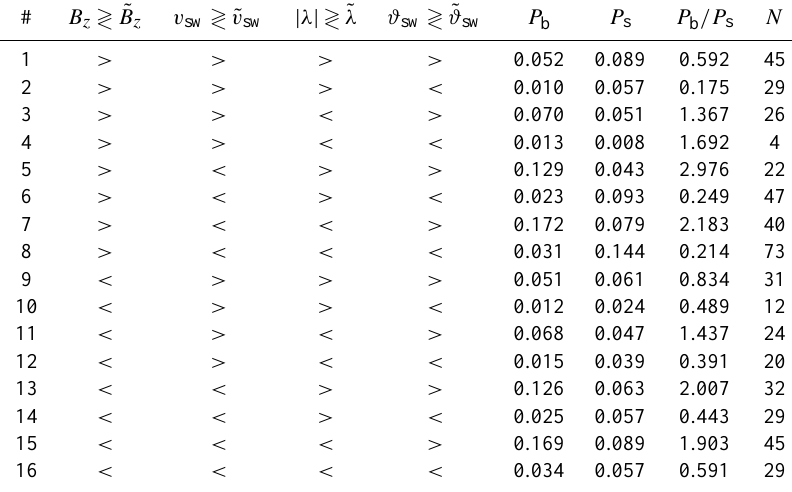
Table 1. Probability of occurrence of events in the basic population ( P b , column 6) and in the sample population ( P s , column 7) with the conditions specified in the columns 2 to 5. The threshold levels are: ˜ B z = 0nT, ˜ v sw = 500km / s, ˜ λ = 40 ◦ and ˜ ϑ sw = 30 ◦ . The last two columns indicate the weighting factor P b /P s applied to the half-period events and the number of events N in the corresponding